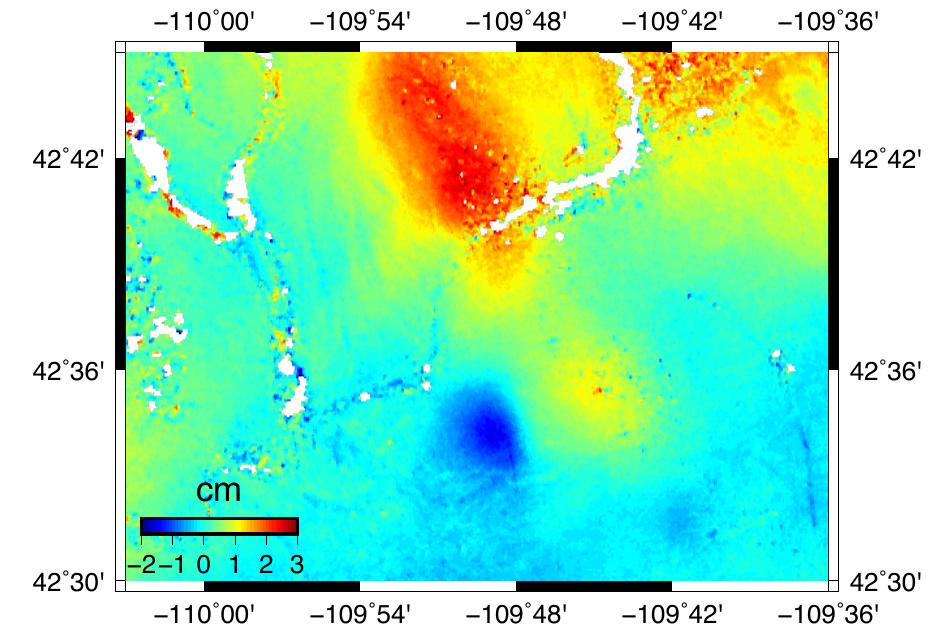
Figure 12. Unwrapped interferogram at Jonah Field, WY, from ALOS-1 spanning the period from 19 May 2008 to 25 May 2010, showing areas of uplift and subsidence possibly related to hydrocarbon